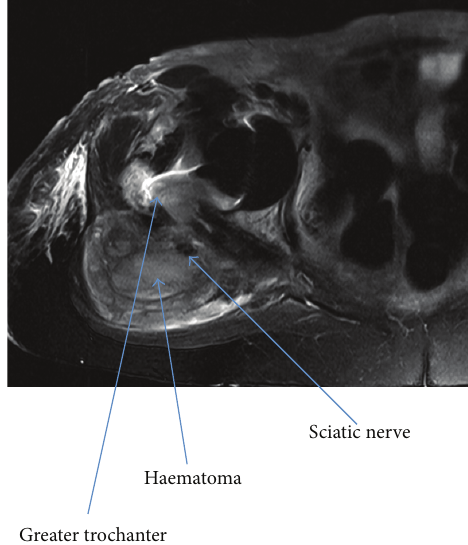
Figure 1: Axial T2 MRI scan showing the haematoma compressing the sciatic